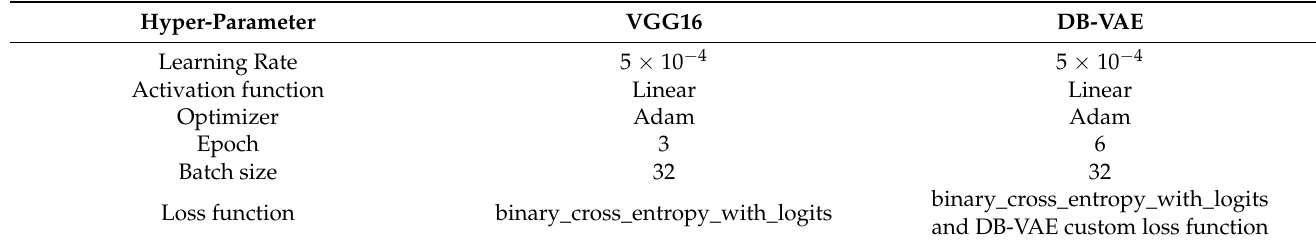
Table 4. Hyper-parameters for experiments with VGG16 and